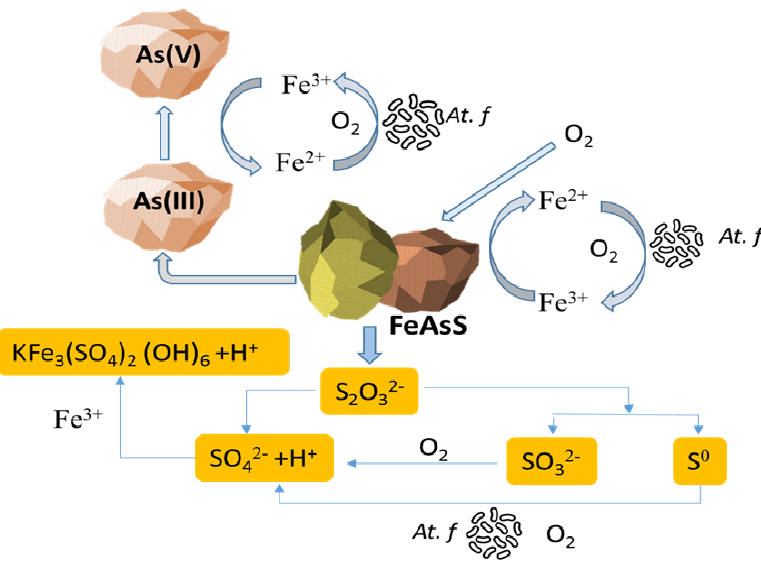
Figure 7. The mechanisms of bioleaching of arsenopyrite from the mine tailings for the removal of arsenic.